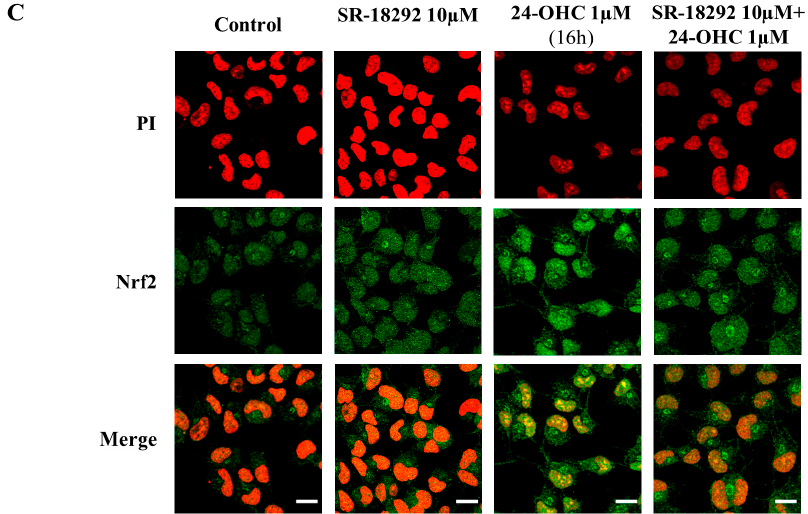
Figure 3. Effect of 24-OHC on Nrf2/KEAP1 and Nrf2/Cul3 complexes and nuclear translocation of Nrf2 in SK-N-BE neuroblastoma cells. Inhibition of PGC1 α prevents Nrf2 nuclear translocation. ( A ) Both Nrf2/KEAP1 and Nrf2/Cul3 complexes were analyzed by Western blotting in cells treated with 1 µ M 24-OHC up to 24 h. Representative blots are shown. The histograms represent mean values ± SD of three experiments. Densitometric measurements are expressed as percentage of control value. * p < 0.05, ** p < 0.01, *** p < 0.001 vs. control. ( B ) Cells were treated with 1 µ M 24-OHC for 6, 16, and 24 h or ( C ) cells were pre-treated (3 h) with 10 µ M SR-18292 and then treated with 24-OHC for 16 h. Nrf2 nuclear translocation was detected by confocal laser microscopy equipped with a Plan-Apochromat 63x/1.40 DIC oil immersion objective. Nuclei were stained with PI (exciting max/emission max: 535 nm/617 nm) and Nrf2 was revealed by a fluorescent probe (Alexa Fluor 488, exciting max/emission max: 490 nm/525 nm). The images are representative of two experiments (( B ) scale bar 30 µ m; ( C ) scale bar 15 µ m).